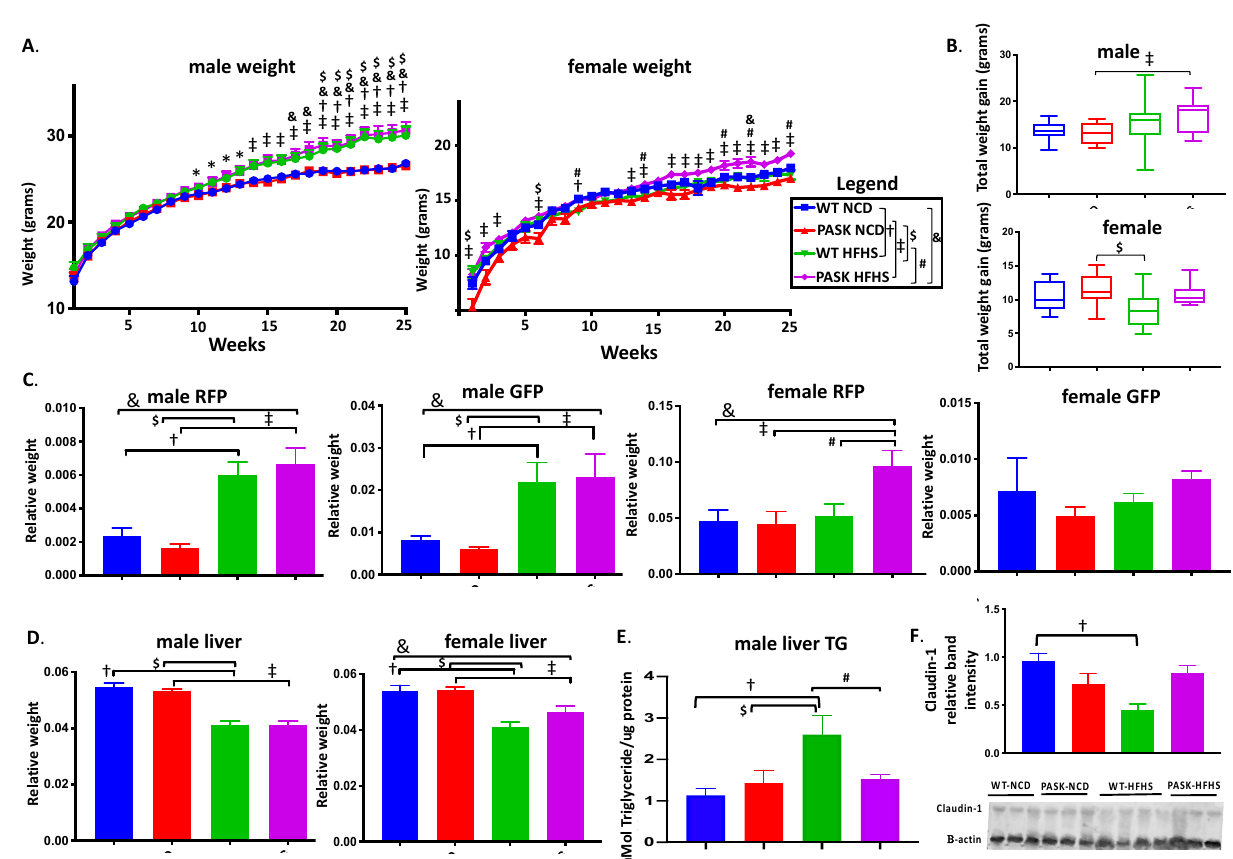
Figure 1. Diet, influenced by genotype, alters body and tissue weight of WT and PASK-deficient (PASK) mice. ( A ) Weekly body weight of male and female mice displays weight gain in response to HFHS diet. ( B ) Total weight gain of male and female mice. ( C ) Relative tissue weights of male and female retroperitoneal fat pad (RFP) and gonadal fat pad (GFP) expressed as tissue weight/final body weight. ( D ) Male and female relative liver weight (tissue weight/final body weight). ( E ) Hepatic triglyceride (TG) accumulation of male mice ( n = 4–8). ( F ) Representative immunoblots of colon claudin-1 levels n = 5–7 per group. B-actin was used as an immunoblot loading control. All data are expressed as mean ± SE. All groups n = 13–19 with the exception of male liver TG and claudin-1 immunoblot. Factorial ANOVA (JMP Pro version 14) followed by post hoc Tukey HSD statistical analysis was performed on male and female mice individually because statistical differences were observed for both sexes at all time points. P -values less than or equal to 0.065 are shown (WT-NCD compared with WT-HFHS † , NCD compared with PASK-HFHS ‡ , WT-HFHS compared with PASK-HFHS # , NCD compared with WT-HFHS $ , WT-NCD compared with PASK-HFHS & ). A corresponding legend is provided in the top